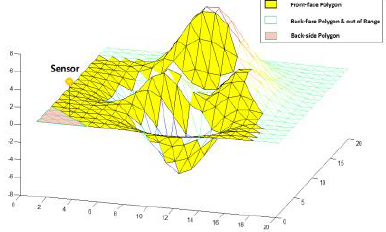
Figure 10. The sample triangulation irregular network